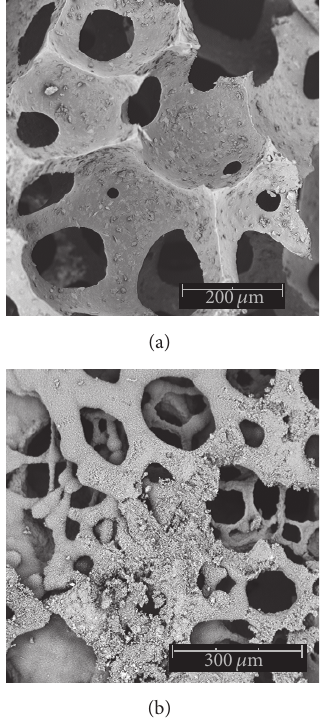
Figure 1: Scanning electron micrograph of latex foam, (a) before and (b) after